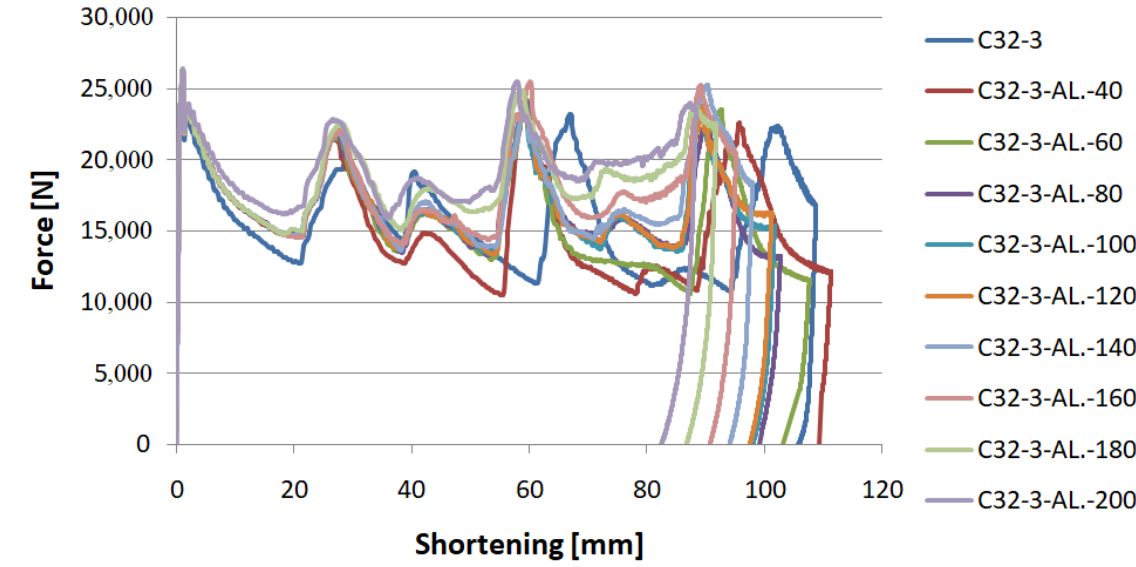
Figure 15. Force-shortening curves with different foam filling on an example of BC trigger.